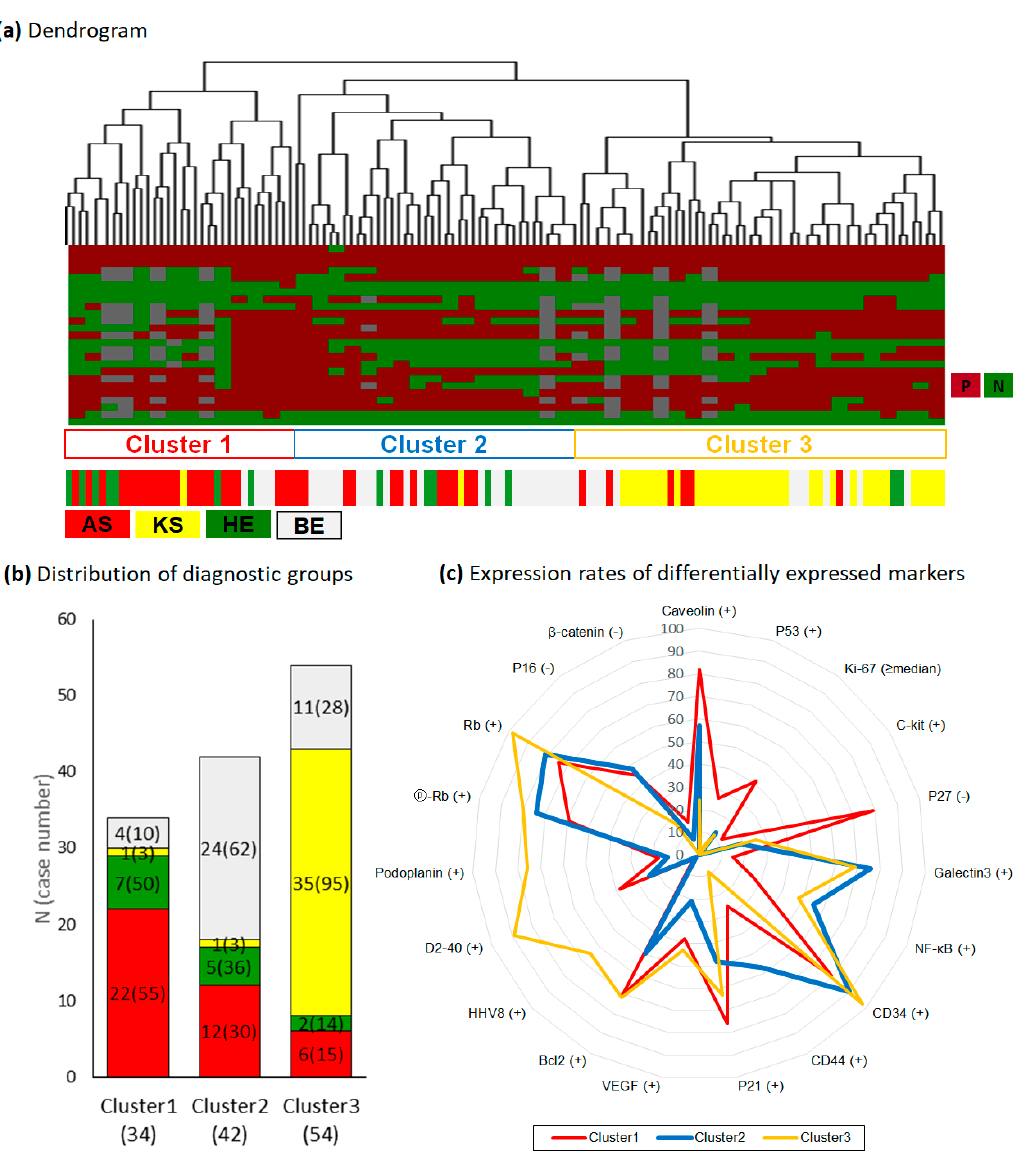
Figure 2. Hierarchical clustering. ( a ) Dendrogram. P: positive, N: negative. ( b ) Distribution of original diagnostic group. N: percentage of case numbers from original diagnostic groups. ( c ) Radar chart of 19 differentially expressed markers within clusters. Table 2. Differentially expressed 19 markers among clusters.